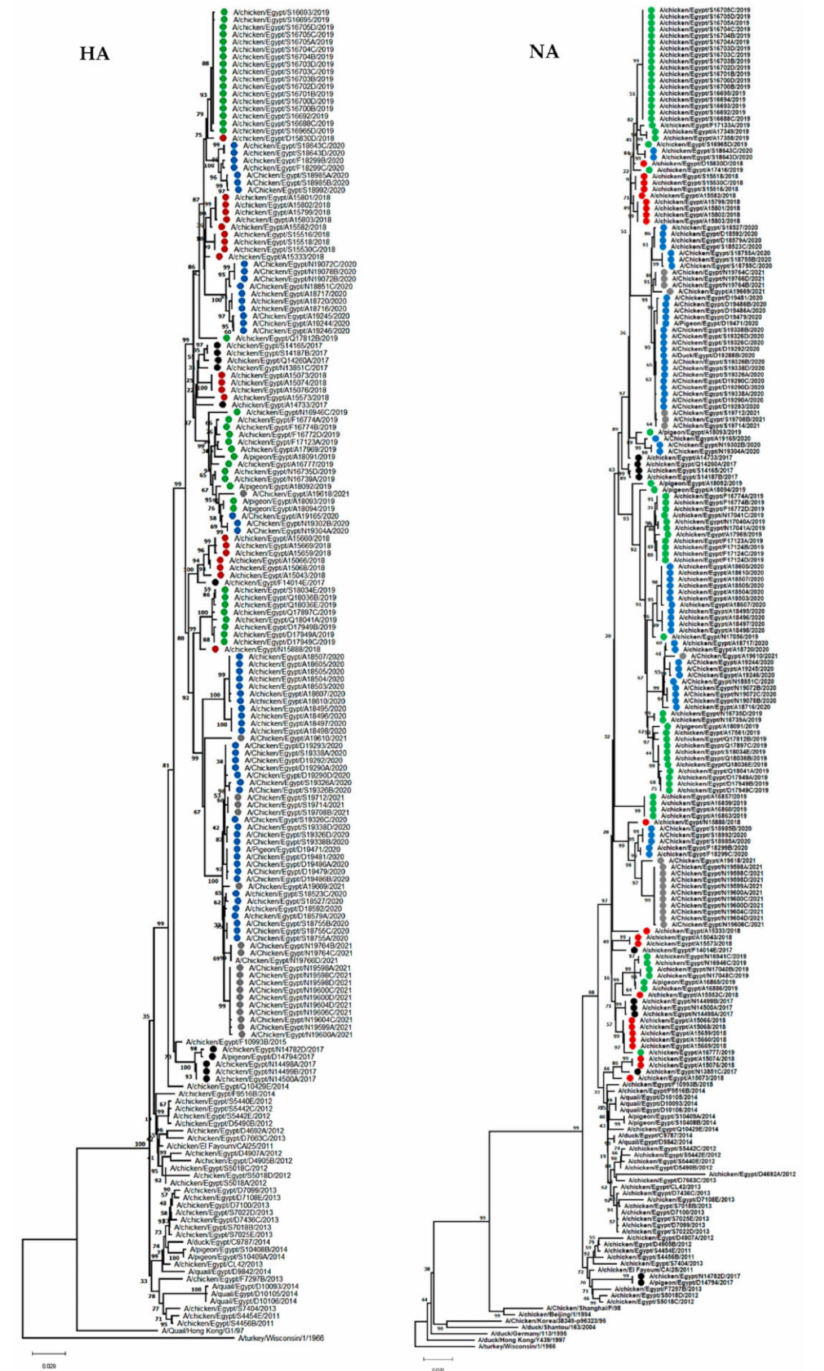
Figure 2. Neighbor joining phylogenetic trees of HA and NA of the detected H9N2 viruses in Egypt. The phylogenetic analysis was performed using MEGA version 7, and the evolutionary distances were computed using the Kimura 2-parameter method. H9N2 viruses sequenced specifically for this study are labeled with colored circles (2017 black, 2018 red, 2019 green, 2020 blue, and 2021